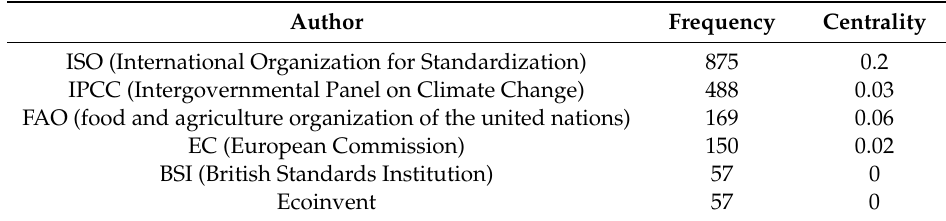
Table 4. Top 6 group authors based on cited